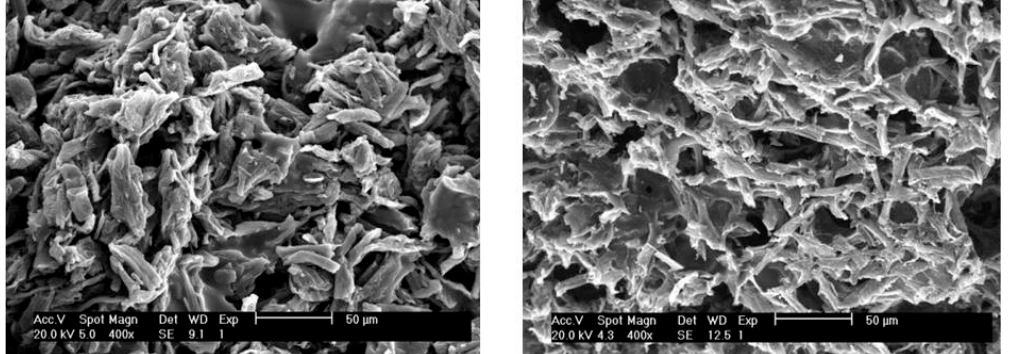
Figure 3 . SEM images of carbons from microcrystalline cellulose and different amounts potato starch: 10 wt. % ( left hand side ) and 50 wt. % ( right hand side ) .